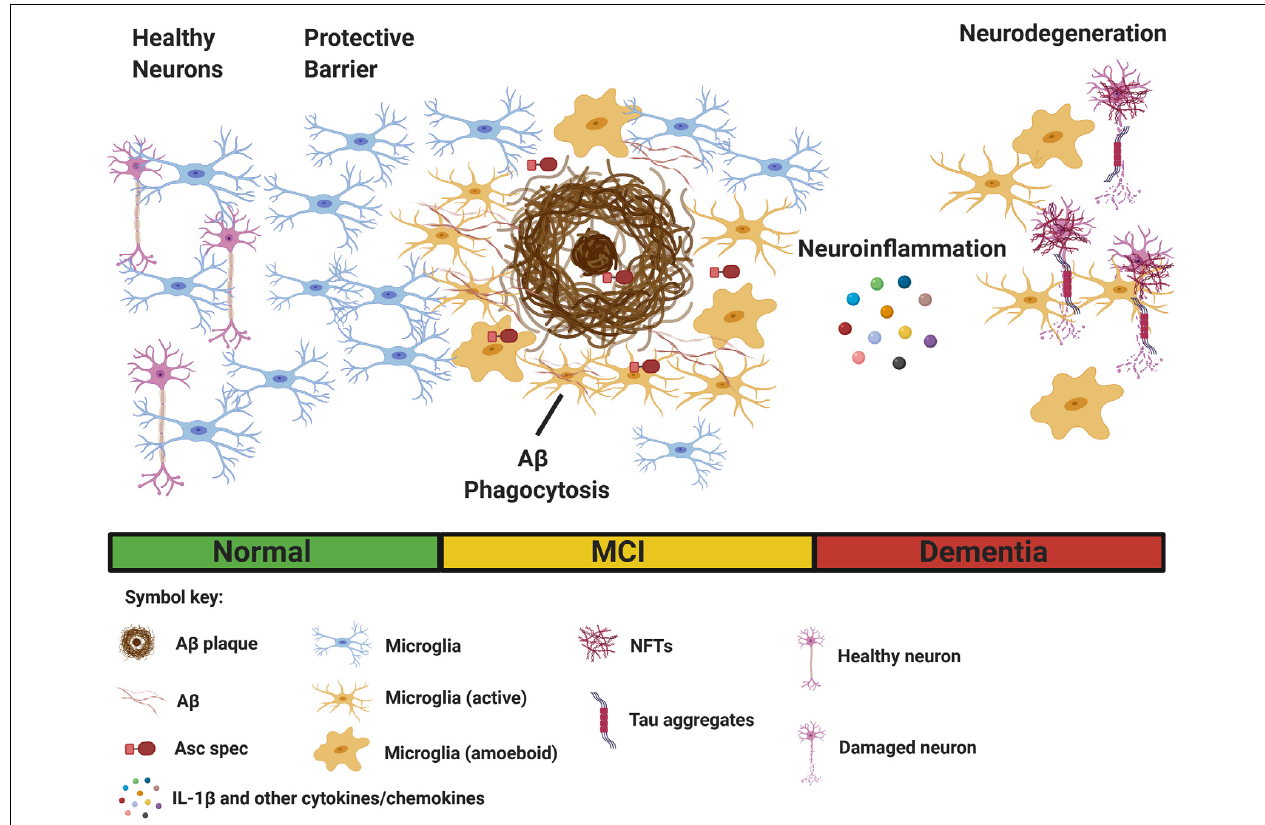
FIGURE 1 | Multiple functions of microglia in Alzheimer’s disease (AD). Microglia sense pathological A β accumulation in the brain, and rapidly respond to the site of injury. (Left) Initially, microglia provide protective functions by facilitating A β clearance through phagocytosis to restore tissue homeostasis. Microglia also acts as a protective barrier to inhibit plaque expansion and contact with adjacent, healthy neurons. (Right) In contrast, sustained microglial activation promotes detrimental effects such as inflammasome activation and the secretion of IL-1 β and other inflammatory cytokines and chemokines, leading to neuroinflammation. Asc specs, formed following NLRP3 inflammasome activation, and released by microglia, also seed new A β plaques. Finally, chronic neuroinflammation enhances the aggregation of hyperphosphorylated tau in neurofibrillary tangles (NFTs), resulting in neurodegeneration. (Bottom) Clinical stages of AD [normal, mild cognitive impairment (MCI), and dementia]. The figure was created with